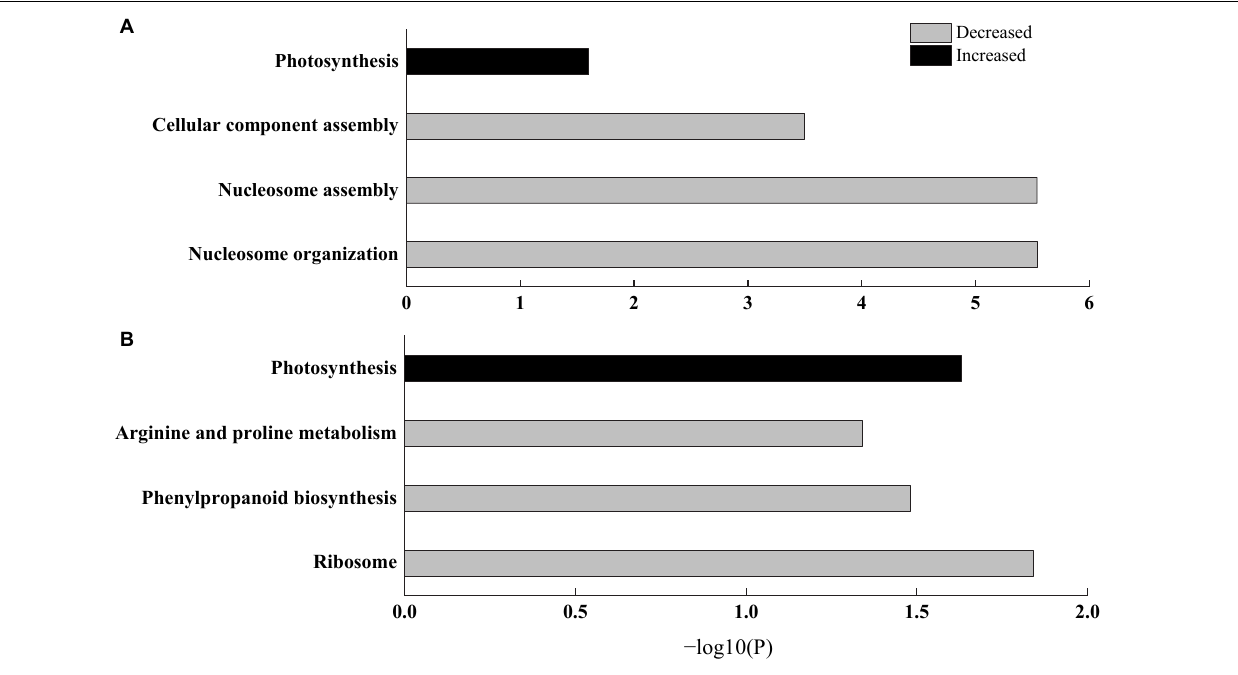
FIGURE 6 | Enrichment analysis of differential protein. (A) GO biological process analysis. (B) KEGG pathway analysis. The bars represent –log10(P) where P represents the Fisher’ exact test P -values.